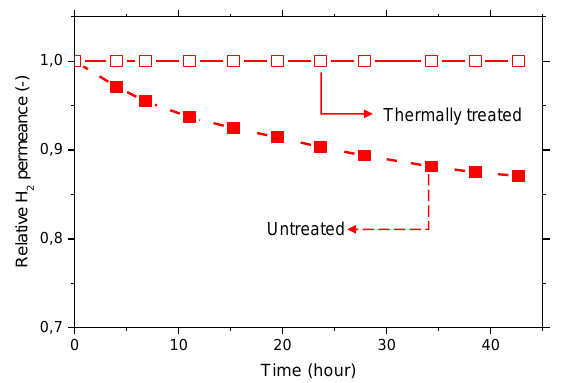
Figure 6. Relative H 2 permeance at room temperature stabilization test. For untreated and thermally treated 6FDA-6FpDA membrane (5 wt. % polymer solution) supported on alumina Anodisc. Permeance values and ideal selectivities for the thin film polymer layers were characterized by using the pressure increase facility. CO 2 and O 2 permeance, as well as CO 2 /CH 4 and O 2 /N 2 selectivities